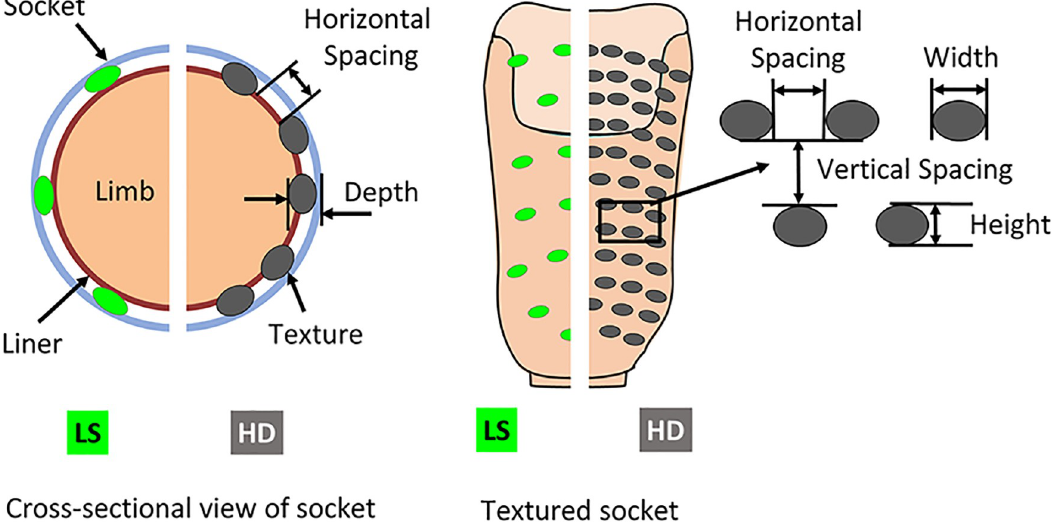
Fig 1. A. Texture presented in cross-section and B. interior views of 3D printed light and sparse (LS) and heavy and dense (HD) prosthetic sockets.